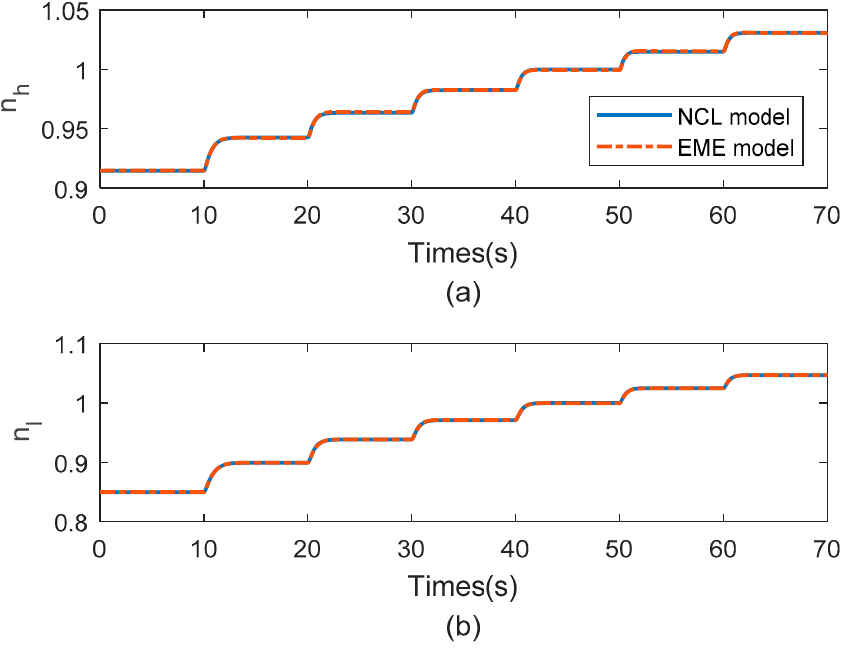
Figure 4. State responses ( a ) 𝑛 (cid:3035) and ( b ) 𝑛 (cid:3039) of the EME model and the engine.